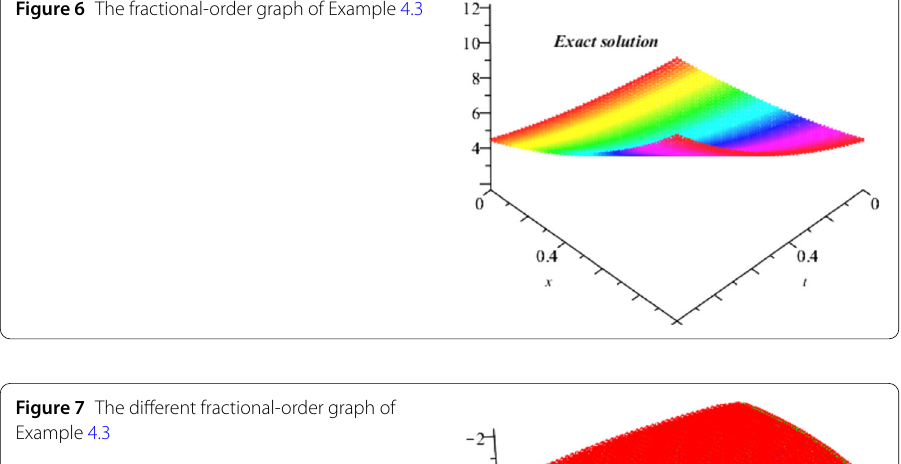
Figure 7 The different fractional-order graph of Example 4.3